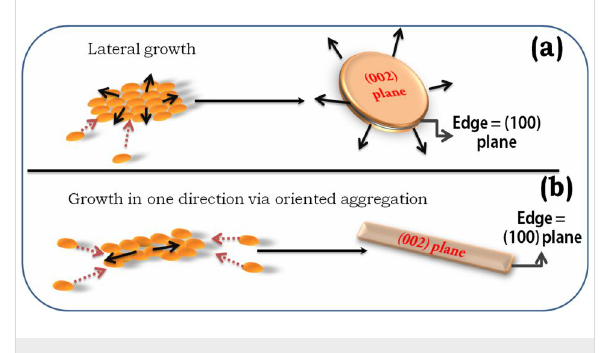
Figure 8: Growth under low and high driving forces. (a) Lateral growth observed under low driving force resulting in nanoplates; (b) elongated shapes are preferred at high-driving forces because of oriented aggre- gation of monomers. Black arrows indicate the growth direction, dotted red arrow show deposition of monomer by